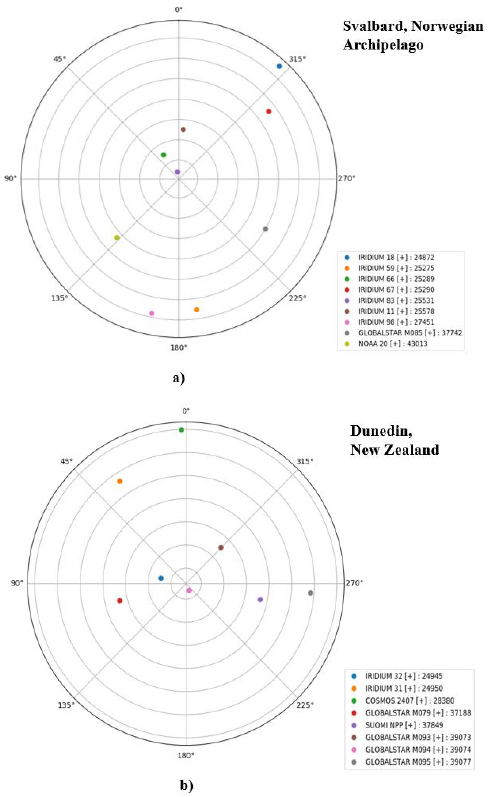
Figure 8: Location-based visualisation in polar regions, a) Svalbard, Norway and b) Dunedin, New